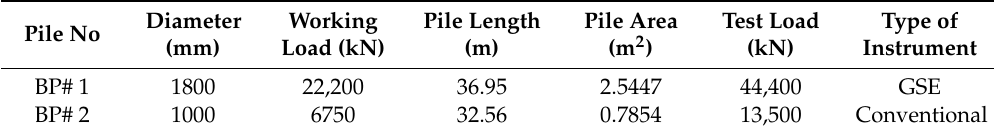
Table 1. Instrumental bored pile load test